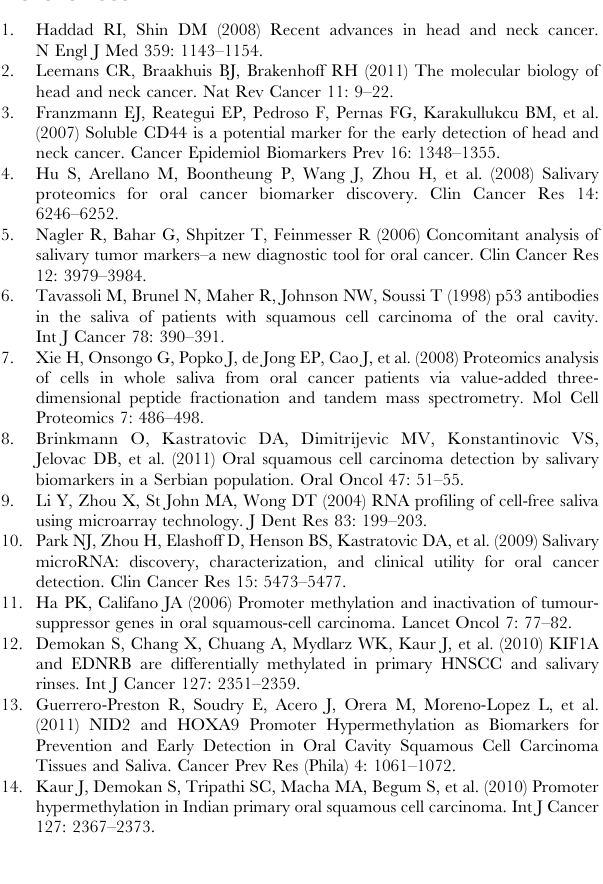
Table S1 Association of each marker in salivary rinses collected with or without brush with selected features. Association between methylation status of each studied gene and clinical and pathologic variable in 57 salivary rinses collected with or without an exfoliating bursh were analysed by multivariate analysis using logistic regression models. Odds Ratios and 95% Confidence Interval was shown in the table. Statistical Significance was indicated as